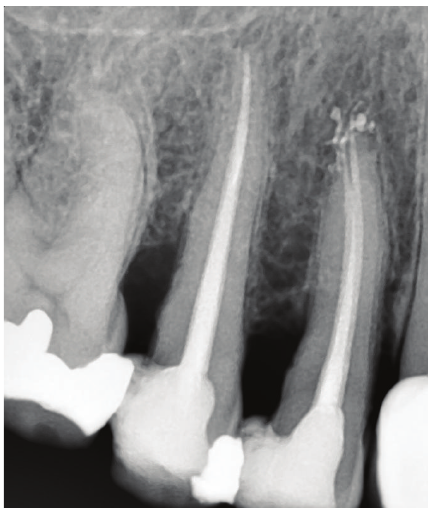
Figure 1: One root and one root canal.